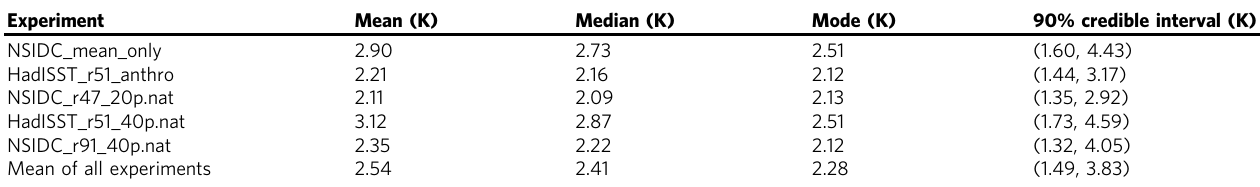
Table 1 Pdf properties of GMST warming to